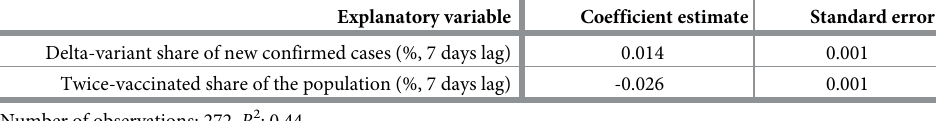
Table 4. Regression of out-of-sample forecast errors of the regression model reported in Table 2. Explanatory variable Coefficient estimate Standard error Delta-variant share of new confirmed cases (%, 7 days lag) 0.014 0.001 Twice-vaccinated share of the population (%, 7 days lag) -0.026